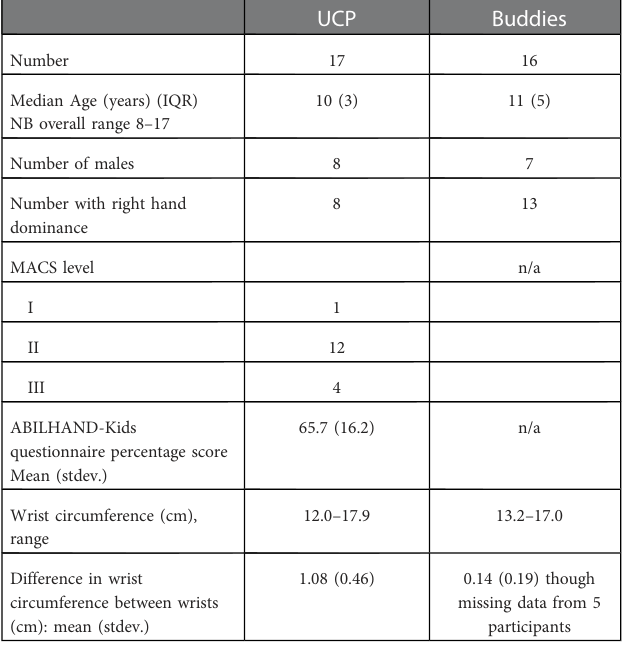
TABLE 1 Characteristics of participants included in the analysis. The two children with UCP who did not complete the study were aged 9 and 11 years, with MACS of 1 and 3 respectively and were both